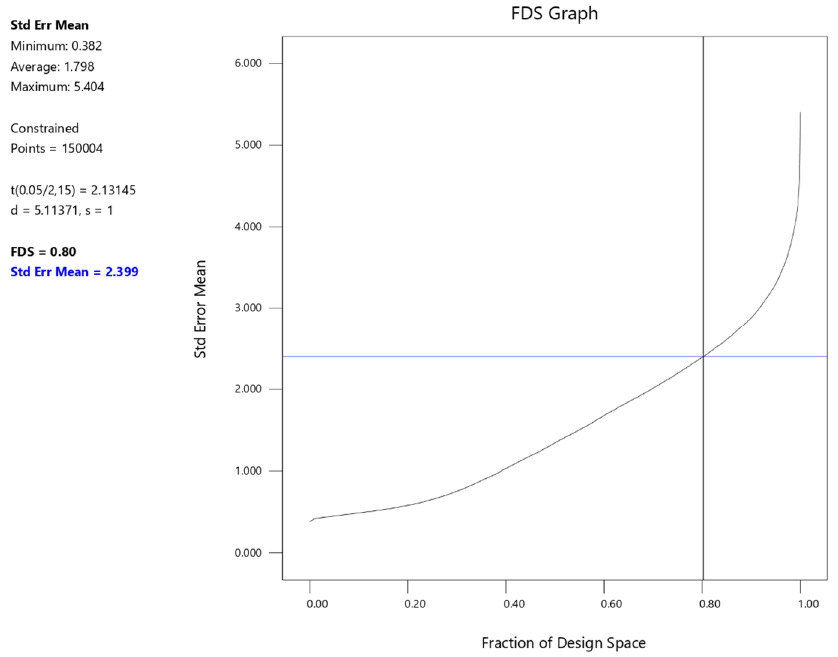
Figure 1. Fraction of design space graph for the evaluated model components and interactions.